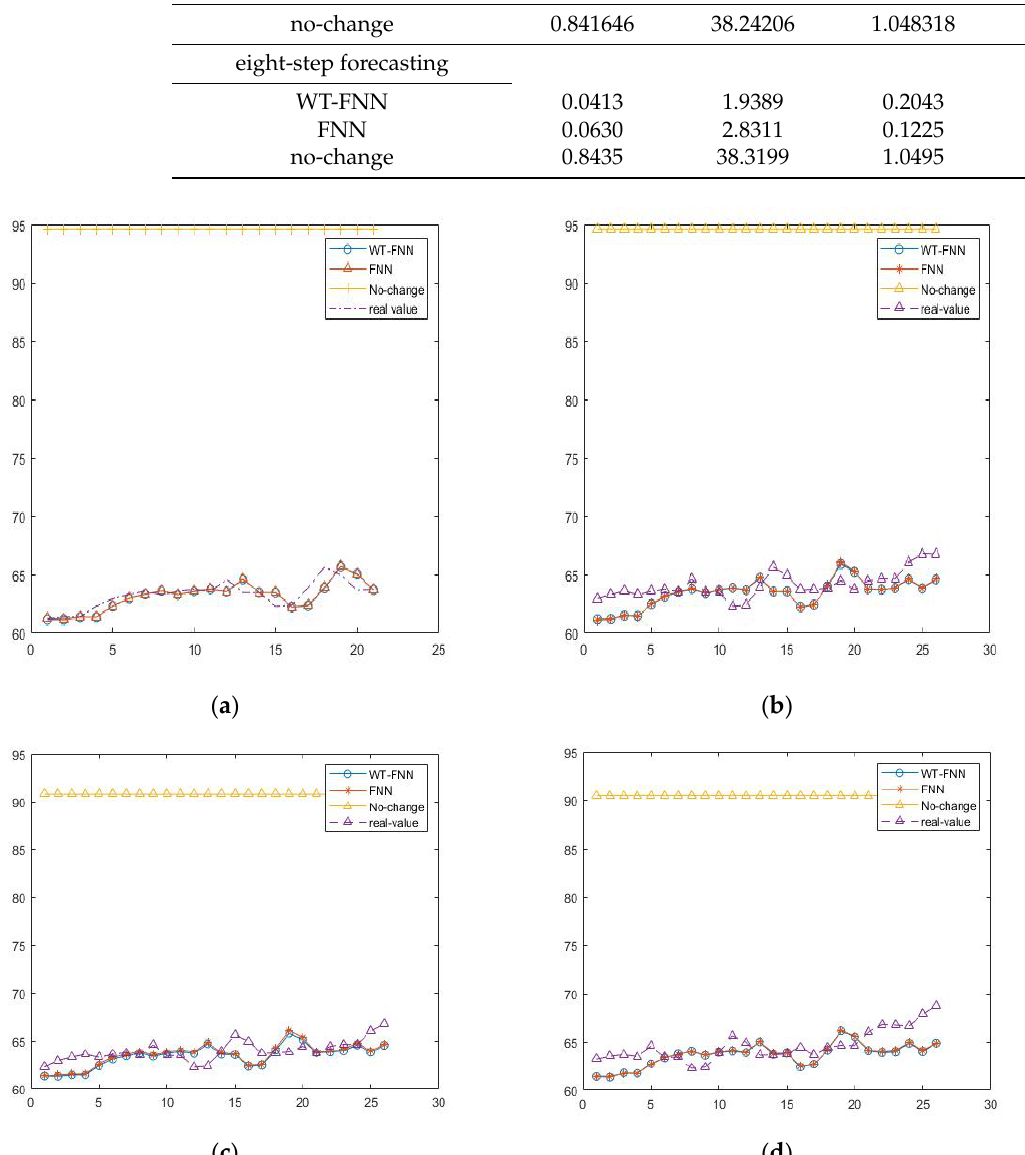
Figure 6. Comparisons of the part predictive data and the actual WTI data for the three models. ( a ) One-step; ( b ) two-step; ( c ) four-step; ( d ) eight-step.